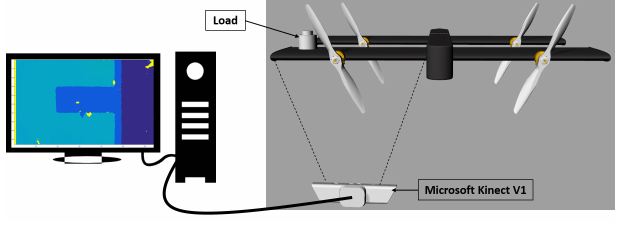
Figure 5. Experimental setup.